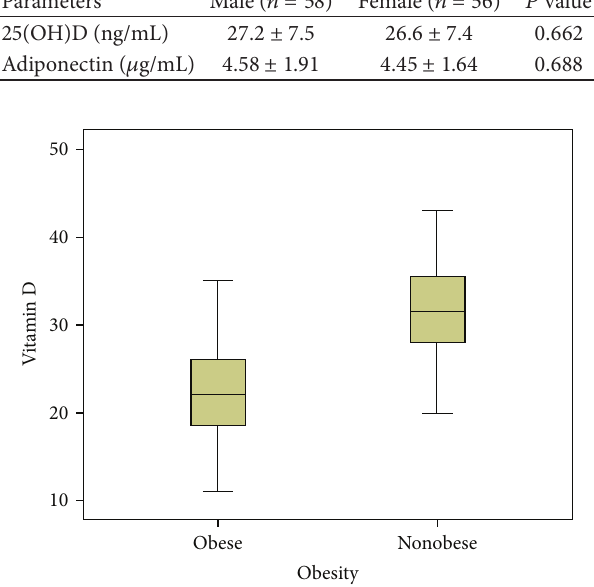
Figure 1: Serum 25(OH)D levels in obese and nonobese